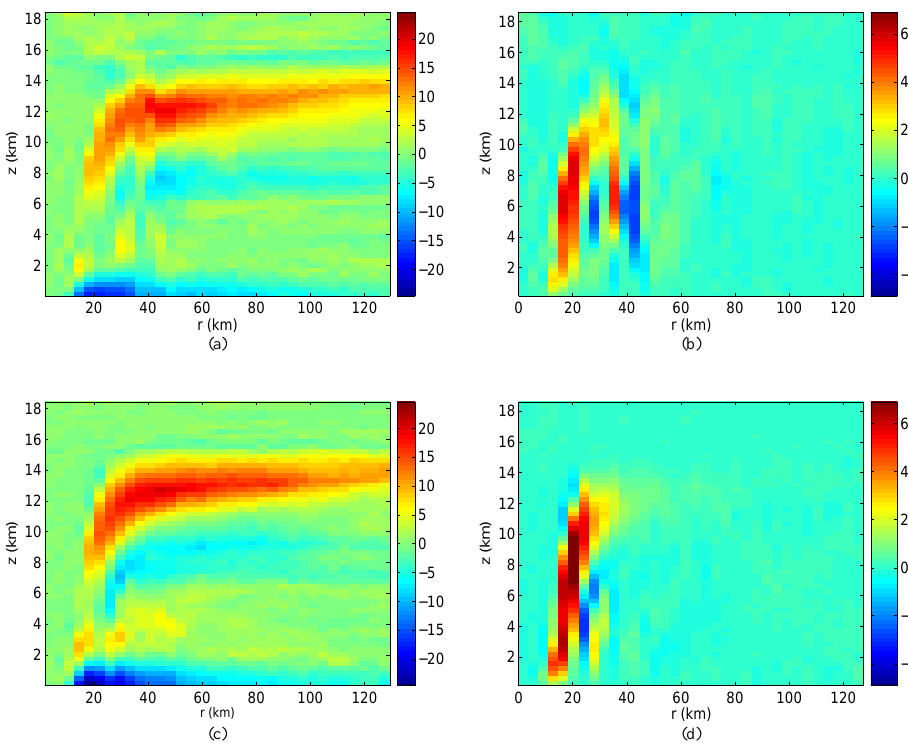
Fig. 9. Weak composite radial (a) and vertical (b) velocity fields, and strong composite radial (c) and vertical (d) velocity fields. outside of the updraft, which may affect the path of particles entering the updraft from the BL inflow. The outflow jet takes a straighter path in the strong composite FTLE field. At the boundary layer, the weak composite FTLE field shows high values where the boundary layer inflow meets the eyewall updraft, allowing fewer trajectories to enter the eyewall. The secondary updraft at 35 km takes some of the boundary layer trajectories through a region with several LCS’s in the forward and backward FTLE fields of both composite fields (Figure 10), and moves them upward into the region just outside of the eyewall, before a downdraft takes them inward to the eyewall updraft. Mixing rates for the composite fields are generally higher for the strong composite field, for both forward and backward integrations, showing that higher intensity coincides with greater mixing. The FRD shows higher values in the boundary-layer inflow region due to the presence of a series of LCS’s that cause